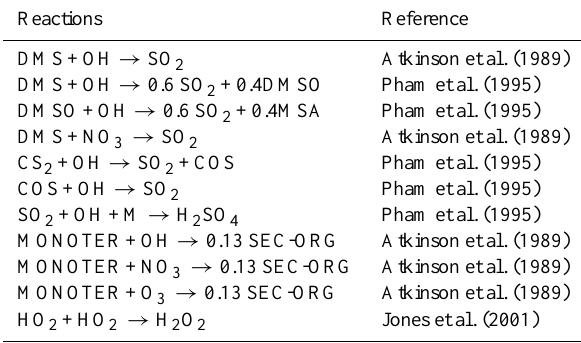
Table 1. Gas phase chemistry used in GLOMAP-mode. An in- volatile organic species SEC-ORG is generated from MONOTER oxidation at 13% yield following reaction rates for α